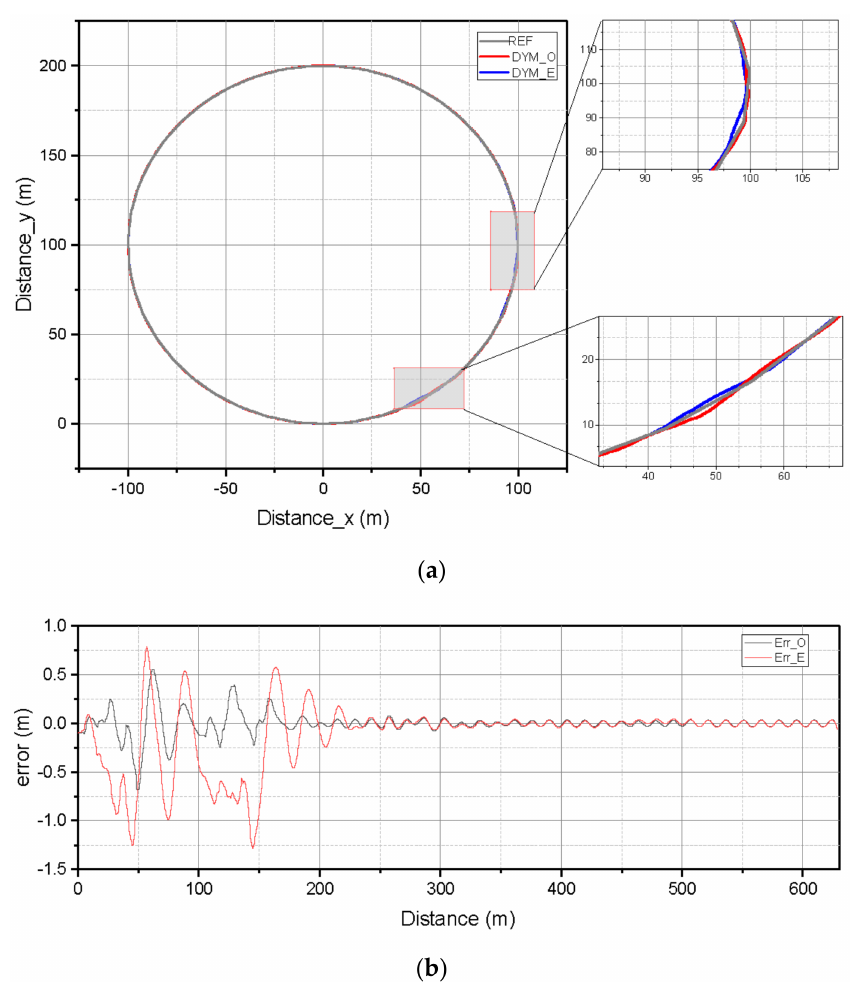
Figure 5. The tracking performance comparison. ( a ) tracking performance comparison; ( b ) tracking error comparison.